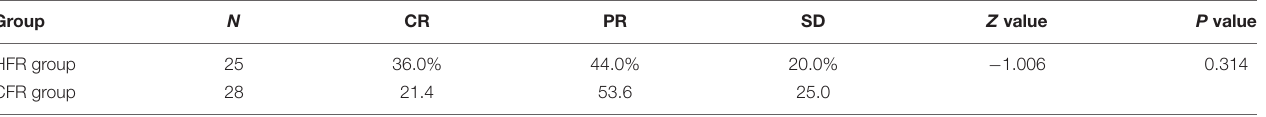
TABLE 3 | Comparison of short-term efficiency between two groups.